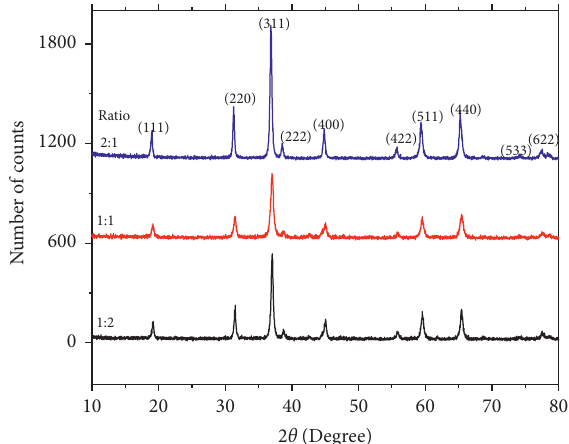
Figure 2: XRD pattern of Solanum tuberosum leaf templated Co 3 O 4